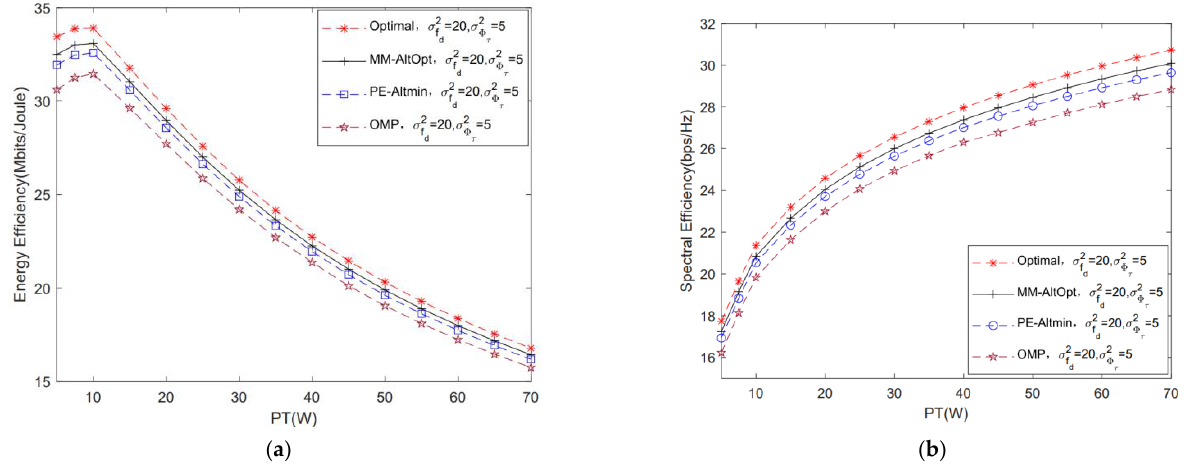
Figure 12. Comparison of system performance of different algorithms for solving F BB and F RF . ( a ) Comparison of system EE of different algorithms for solving F BB and F RF ; ( b ) comparison of system SE of different algorithms for solving F BB and F RF